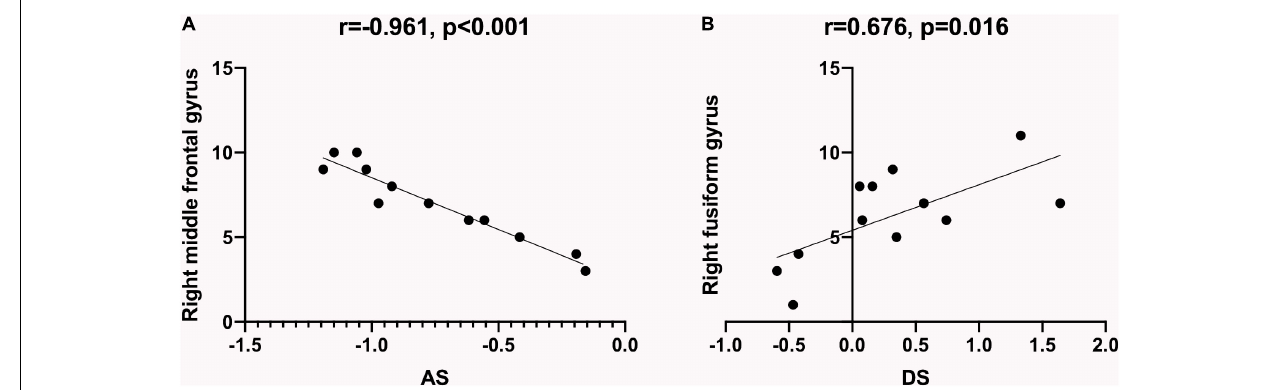
FIGURE 4 | Relationship between ReHo values and emotional state. The ReHo values of specific brain regions in SM patients showed a correlation with HADS, which indicated that SM patients were more prone to be anxious and depressed. (A) ReHo values at the right middle frontal gyrus of the SM group showed a negative correlation with the AS ( r = − 0.961, P < 0.001). (B) ReHo values at the right fusiform gyrus of the SM group showed a positive correlation with the DS ( r = 0.676, P = 0.016). ReHo, regional homogeneity; SM, severe obesity and meibomian gland dysfunction; AS, anxiety scores; DS, depression scores; HADS, hospital anxiety depression